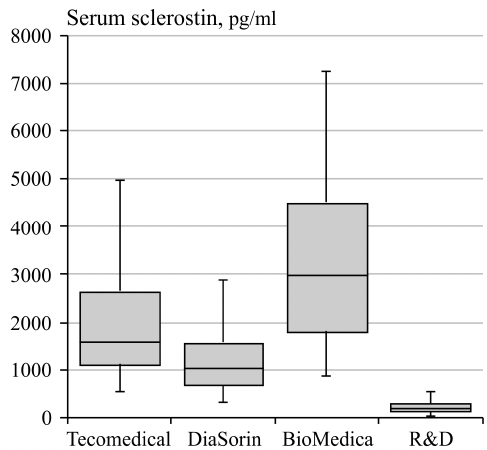
Figure 2. Serum sclerostin levels in the end-stage kidney disease (ESKD) cohort, measured using four different commercially available kits (median, 1st and 3rd percentiles, minimum and maximum). Table 3. Spearman correlation matrix of serum sclerostin concentration, measured by 4 different assays. Note: **** p -value < 0.0001.